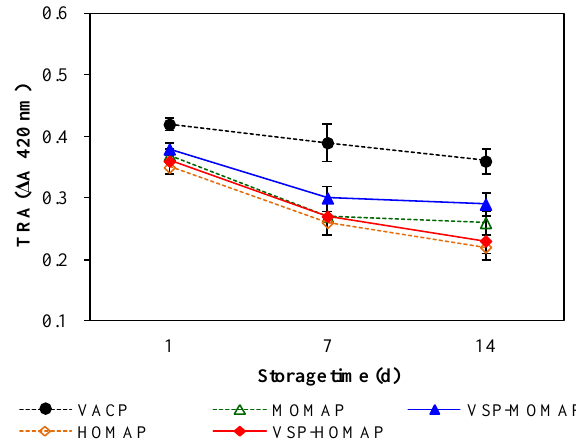
Figure 3. TBARS content in sliced Hanwoo (Korean cattle) beef loin in packaging systems for 14 d at 4°C. Data are presented as means±SD. TBARS, 2-thiobarbituric acid reactive substances; VACP, vacuum packaging; MOMAP, medium oxygen-modified atmosphere packaging (50% O 2 /20% CO 2 /30% N 2 ) alone; VSP- MOMAP, MOMAP combined with vacuum skin packaging; HOMAP, high oxygen-MAP (80% O 2 /20% CO 2 /0% N 2 ) alone; VSP-HOMAP, HOMAP combined with VSP; SD, standard